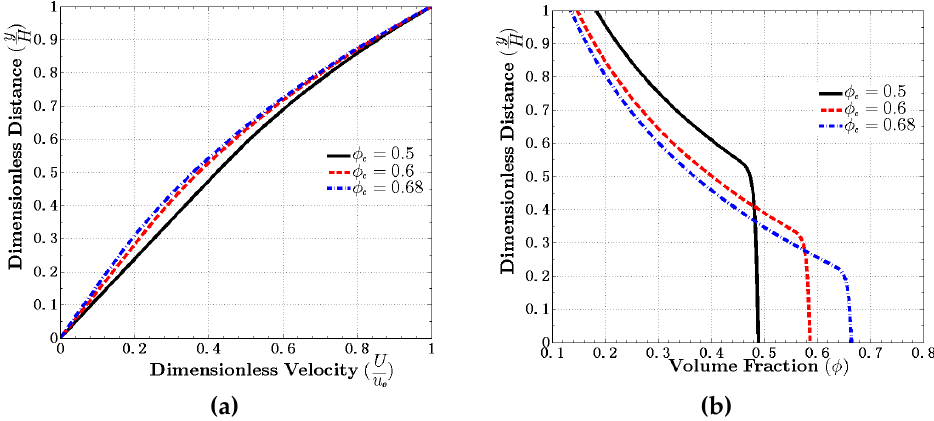
Figure 3. The effect of φ c on the velocity profile ( a ) and the volume fraction profile ( b ), when R = 1, m = 1, ( 2 M 1 + M 2 ) = 1, B p = − 1, B r = − 10, S = 100, Fr = 0.5, N = 0.4.